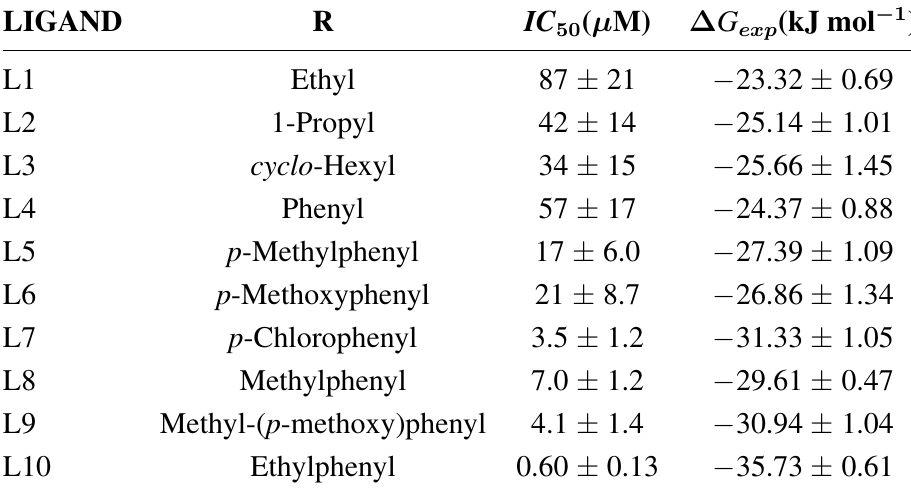
for the thiourea compounds exp values reported in a CYP 2D6 inhibition study 50